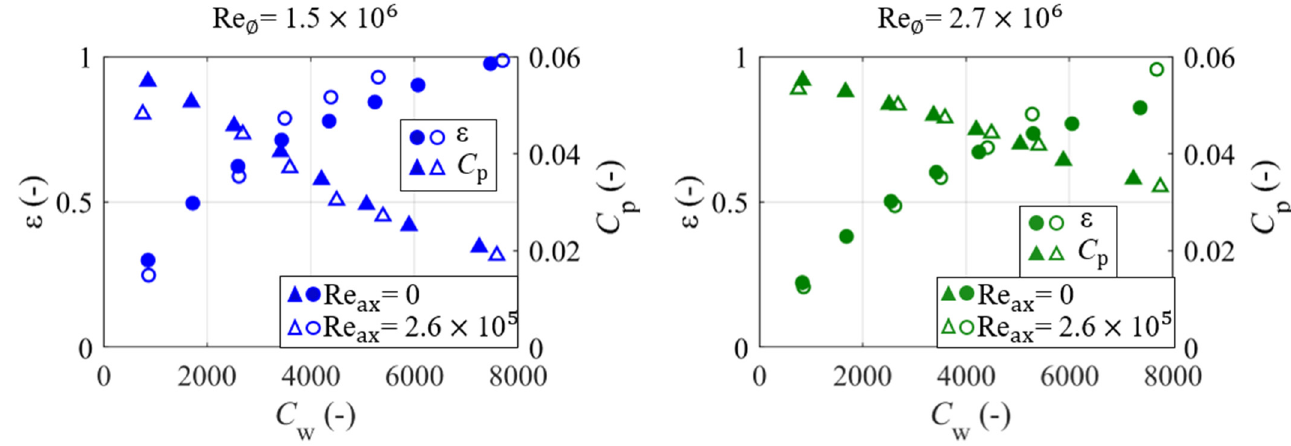
Figure 8. Effect of the axial annulus flow on the sealing effectiveness and cavity pressure difference as a function of the purge supply measured at r / b = 0.99 and s c = 0.0078.